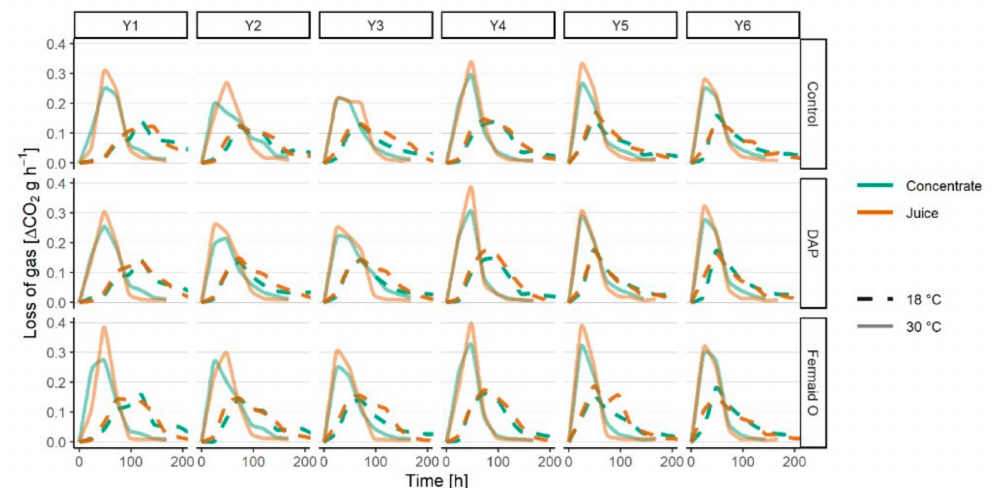
Figure 1. Fermentation kinetics of cider samples prepared from fresh juice or juice concentrate with di ff erent yeasts (Y1-Y6) at 18 or 30 ◦ C. The samples done with the concentrate are represented by a green line and with the juice by an orange line. The samples fermented at 18 ◦ C are represented by a dashed line of appropriate color; by a solid line at 30 ◦